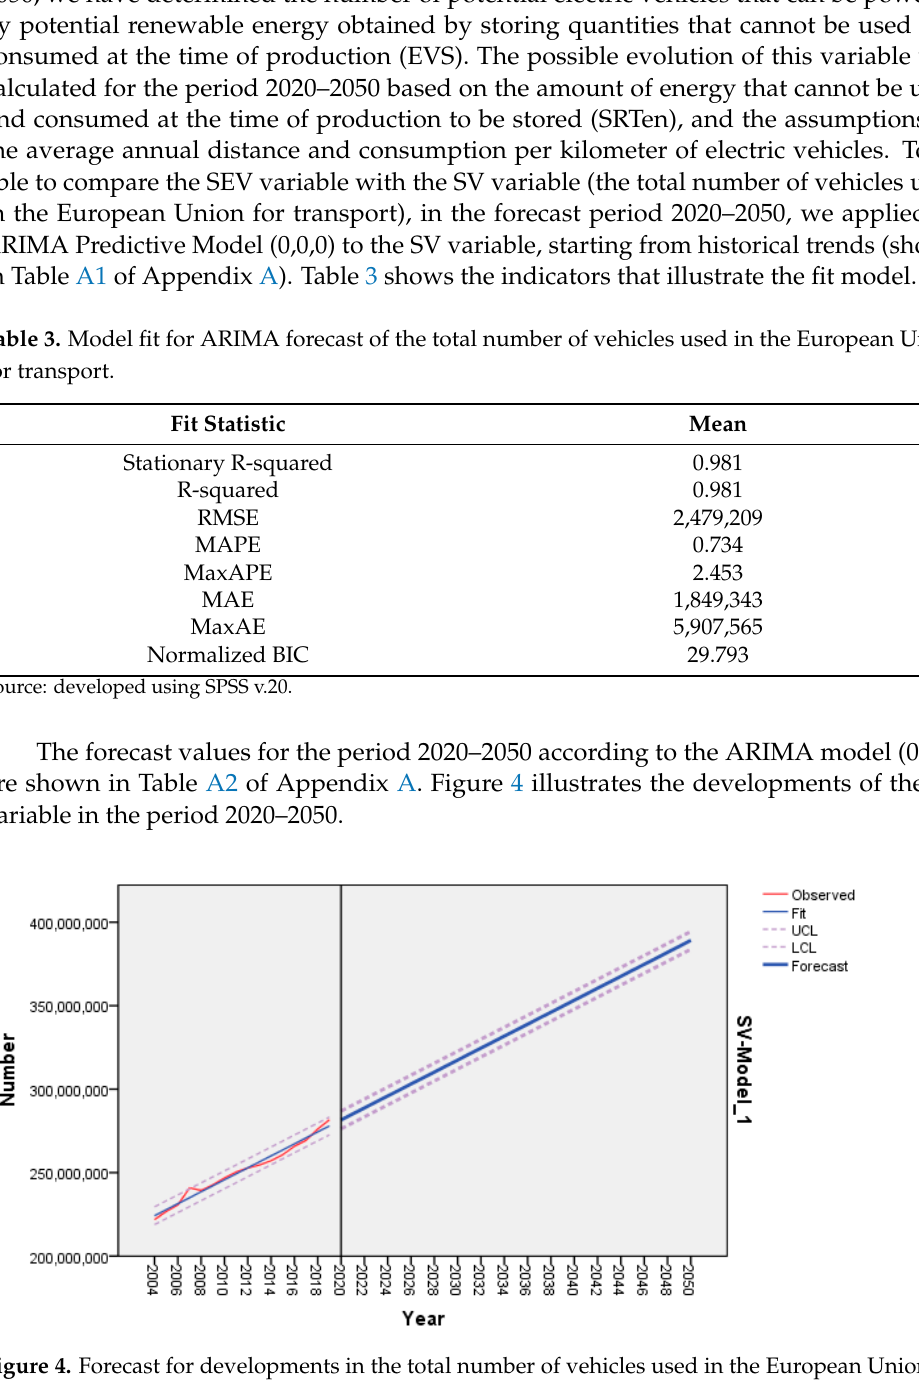
Figure 4. Forecast for developments in the total number of vehicles used in the European Union for transport. Notes: UCL—upper-case limits; LCL—lower confidence limits. Source: developed using SPSS v.20.